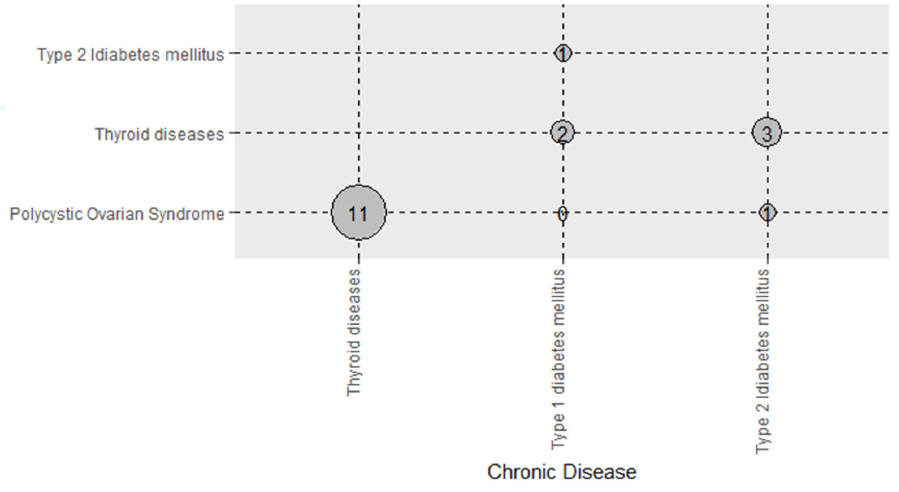
Figure 2. Combinations of endocrine diseases among people with at least two endocrine